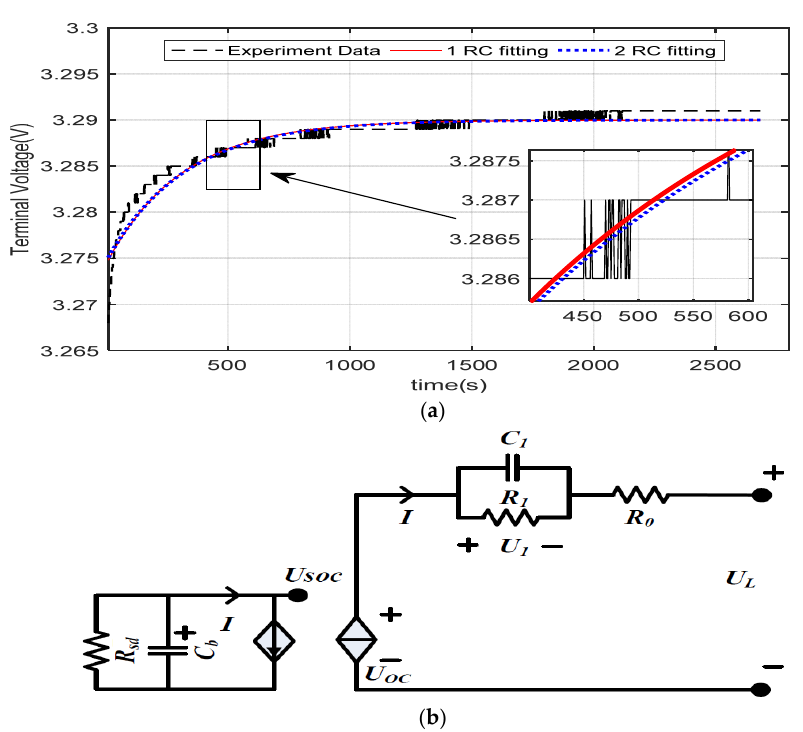
Figure 1. ( a ) Different between one RC and two RC battery cell model; ( b ) battery cell equivalent circuit model.